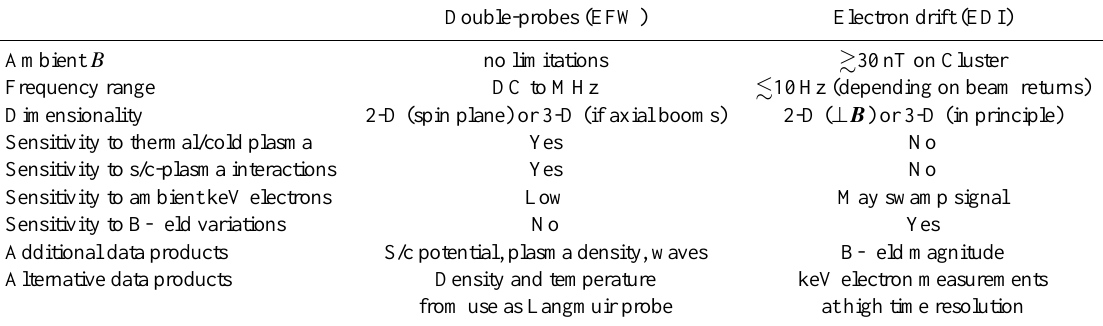
Table 1. Summary of merits and drawbacks of the double-probe and electron drift techniques for magnetospheric electric field measur- ments. The implementations on Cluster, EFW and EDI, provide 2-D measurements. Extending the EDI technique to three-dimensional measurements will require a significant advance over the current state of the